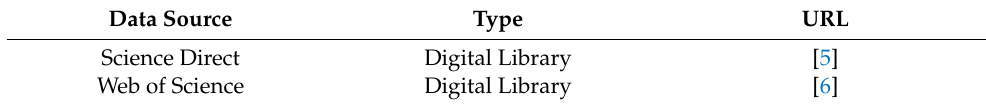
Table 1. Information sources used for the search